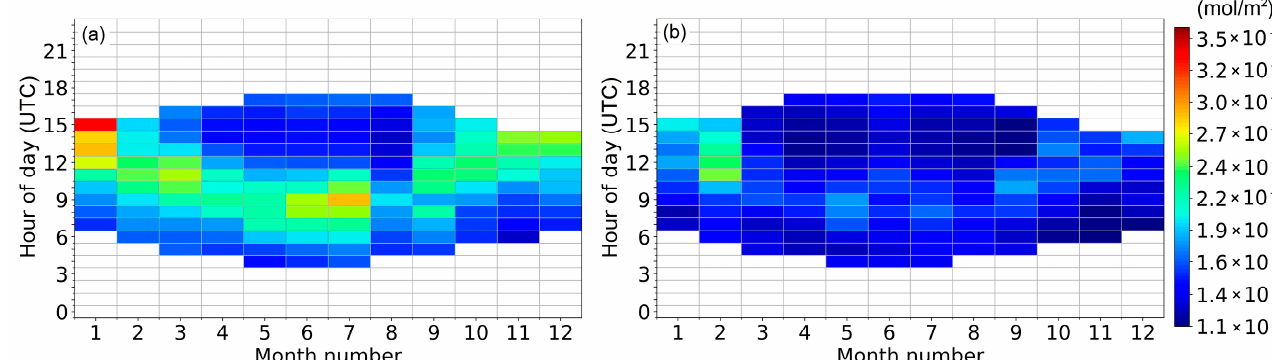
Figure 4. Hourly and monthly variation of VC-NO 2 for ( a ) weekdays and ( b ) weekends over the period 2017–2022.